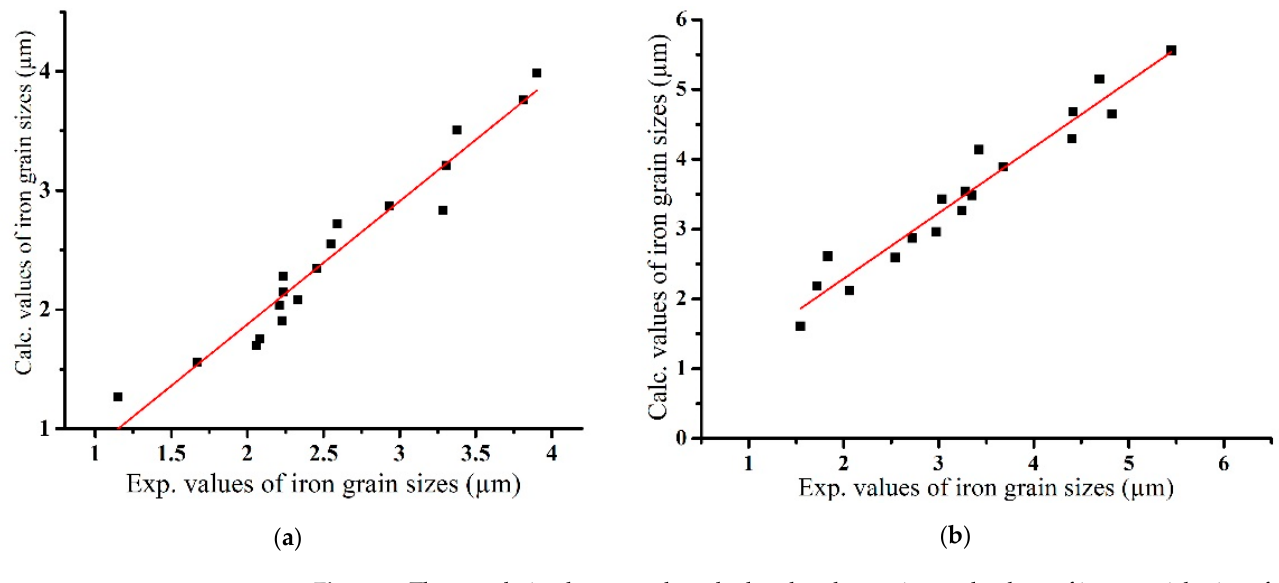
Figure 8. The correlation between the calculated and experimental values of iron particle size after